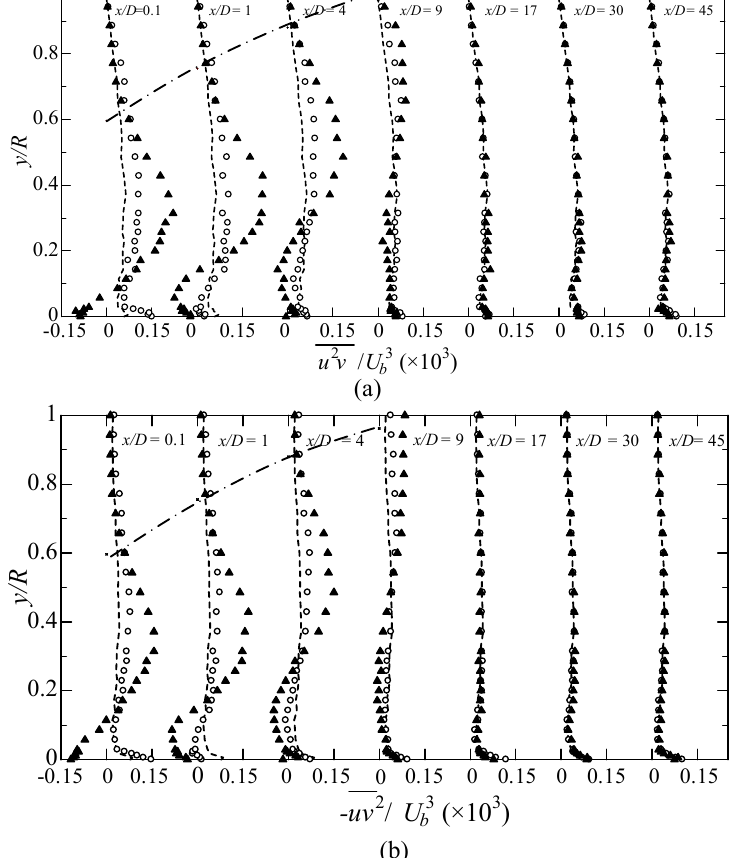
Fig. 9 Triple velocity products of disturbed and undisturbed flow (a) (cid:1873) (cid:2870) (cid:1874)(cid:3364)(cid:3364)(cid:3364)(cid:3364)(cid:3364) and (dot-dash line represents the internal boundary layer thickness) (b) (cid:3398)(cid:1873)(cid:1874) (cid:2870) (cid:3364)(cid:3364)(cid:3364)(cid:3364)(cid:3364) (same symbols as Fig.